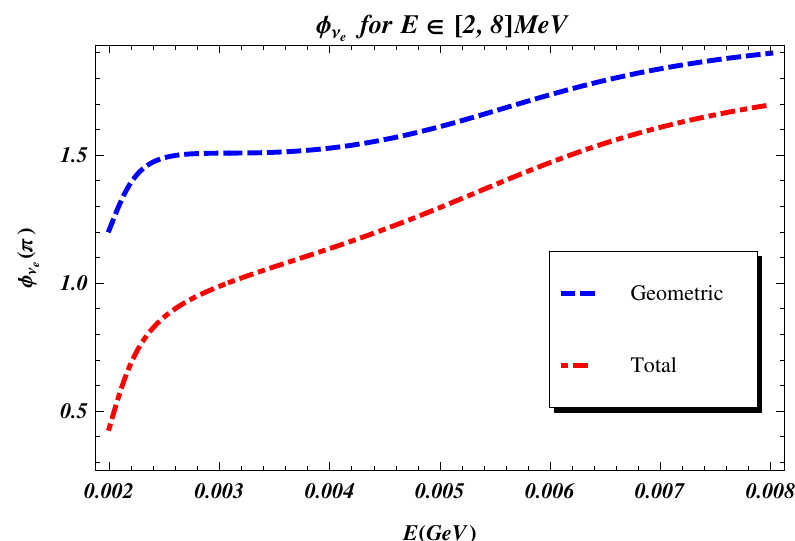
Figure 1. (Color online) Plots of the total and the geometric phases for ν e , as a function of the neutrino energy E , for a distance length z = 100 km. - The red dot dashed line is the total phase; - the blue dashed line is the geometric phase.